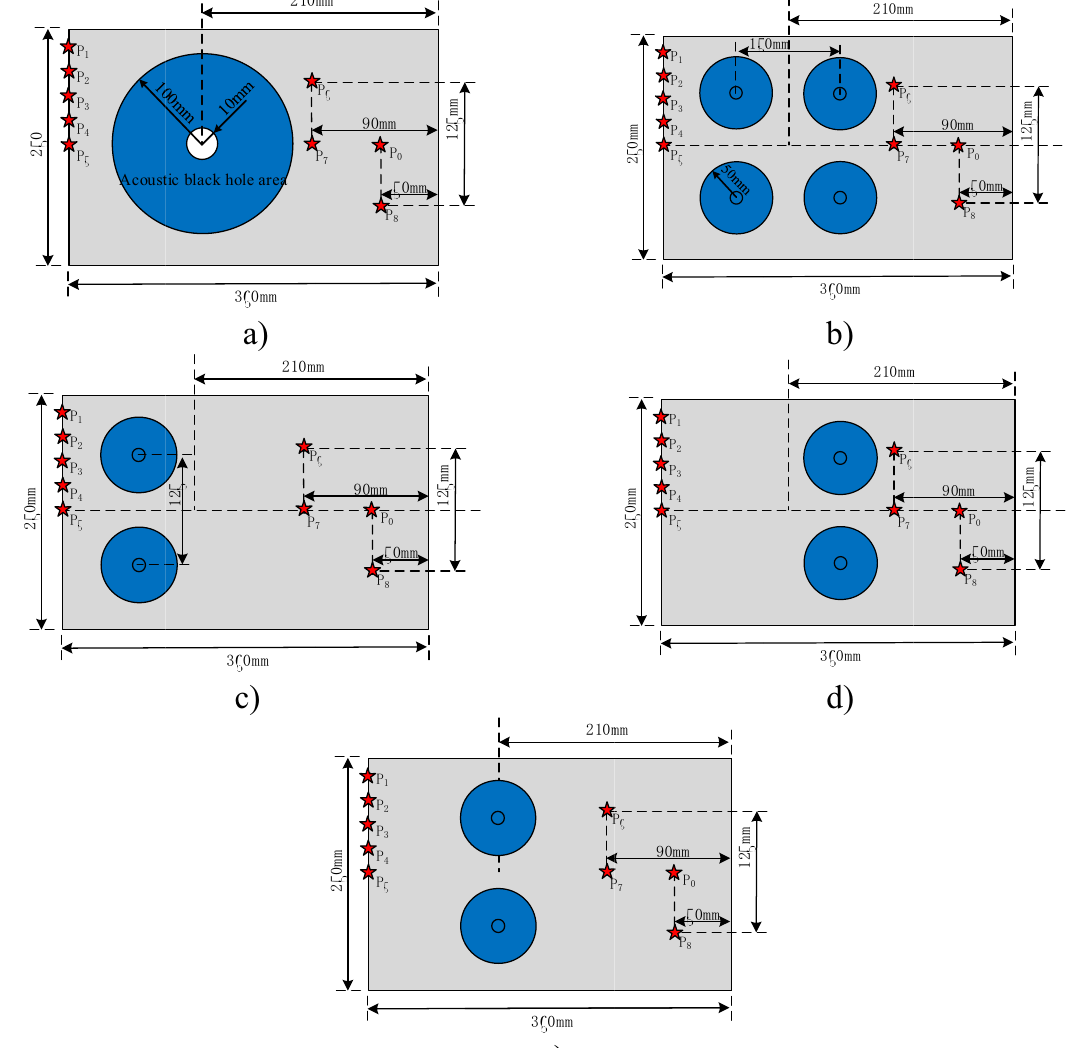
Figure 11: Acoustic black hole plates with di ff erent arrangements. ( a ) Condition 1. ( b ) Condition 2. ( c ) Condition 3. ( d ) Condition 4. ( e ) Condition